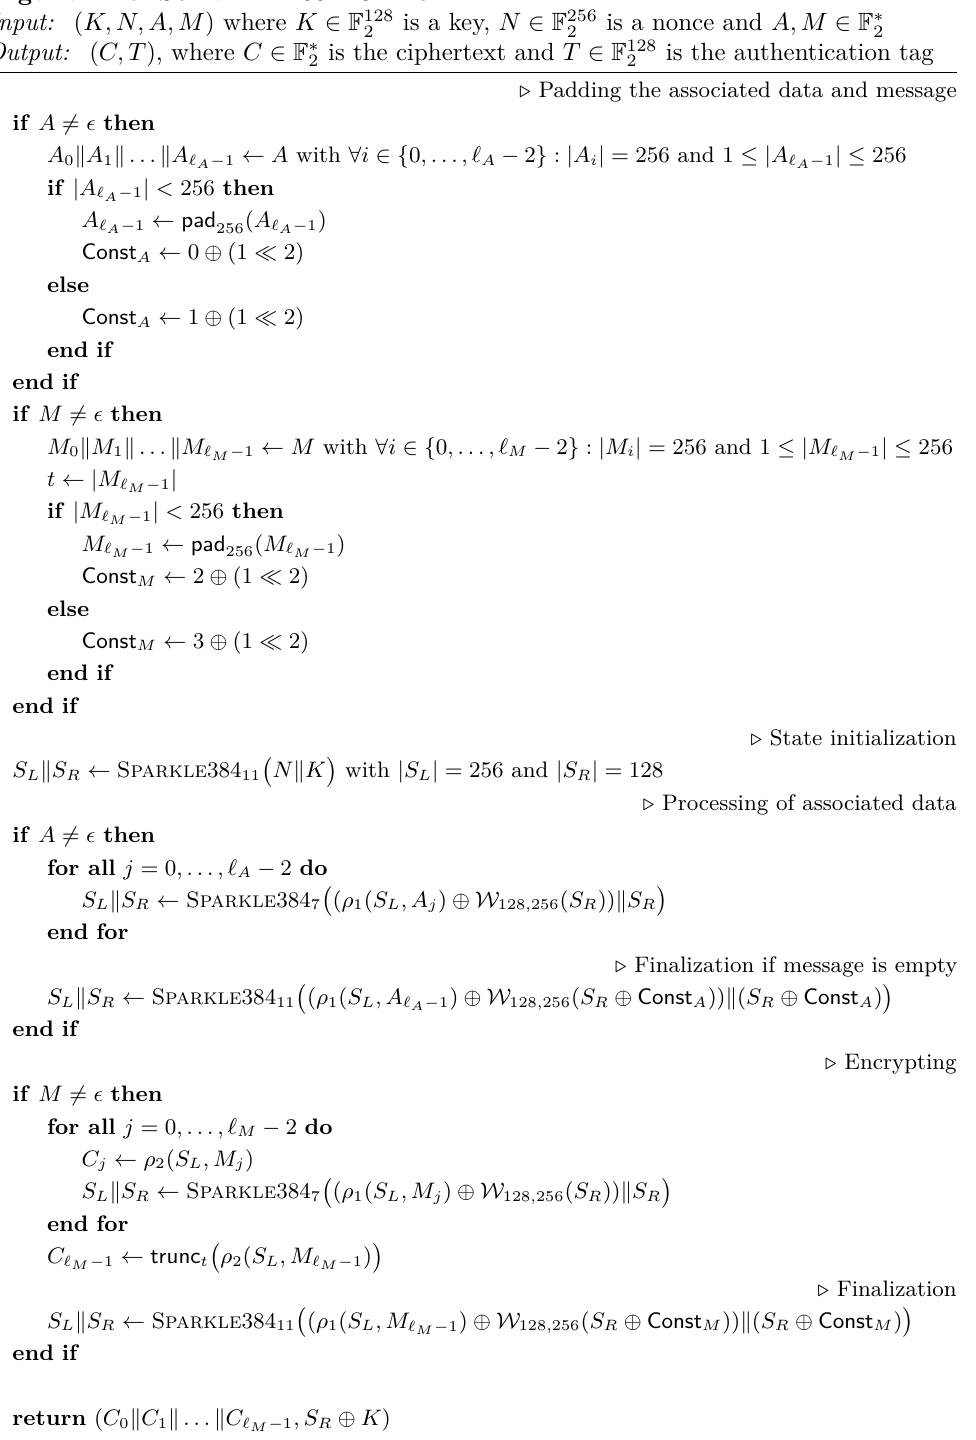
Algorithm 6 Schwaemm 256-128